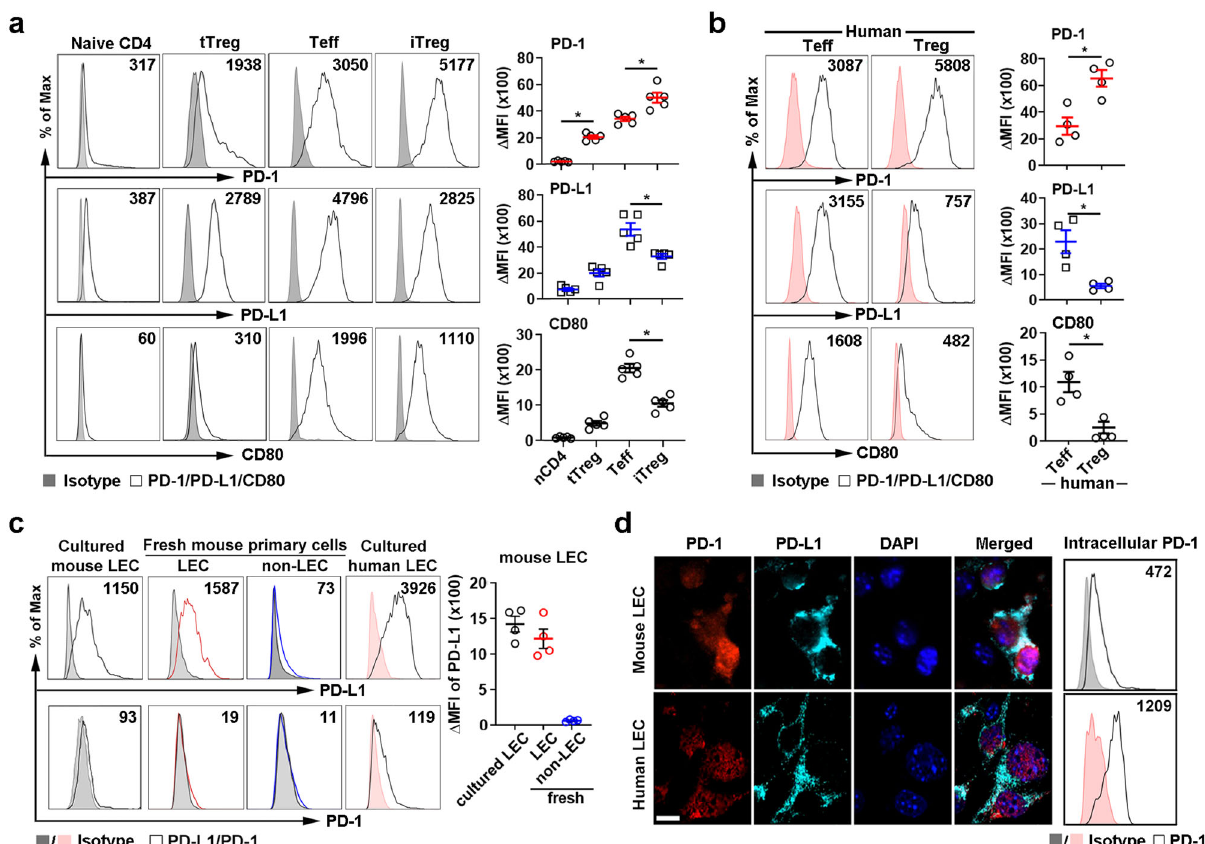
Fig. 1 Cell surface expression of PD-1, PD-L1, and CD80 in T cell subsets and LEC. a – c Flow cytometry analysis of PD-1, PD-L1, and CD80 expression on FACS-sorted mouse Foxp3GFP - CD44 low CD25 − CD4 + naïve CD4 or IL-2 + anti-CD3/28-stimulated activated Foxp3GFP − CD25 + CD4 + Teffs, Foxp3GFP + CD44 low CD25 + CD4 + tTregs or IL-2 + anti-CD3/28 + TGF- β 1-induced Foxp3GFP + CD44 high CD25 + CD4 + iTregs ( a ); human CD4 + CD25 high CD127 − CD45RA − Tregs or CD4 + CD25 − CD127 + CD45RA + Teffs ( b ); or cultured or freshly isolated mouse LECs (Lyve-1 + CD31 + ), mouse non-LECs (Lyve-1 − CD31 − ) and cultured human LECs ( c ). Δ MFI, MFI of Ab staining minus isotype control staining. Mean ± SEM. * p < 0.001 by one-way ANOVA with Tukey ’ s multiple comparison test ( a , c ) and unpaired, two-tailed t -test with Welch ’ s correction ( b ). d Immunohistochemistry of PD-1 and PD- L1 expression and fl ow cytometry analysis of permeabilized LECs. Magni fi cation ×60, scale bar 10 μ m. Intracellular staining of PD-1 in LEC shown. Data representative of 3 ( a – c ) or 2 ( d ) independent experiments. Source data are provided as a Source Data fi